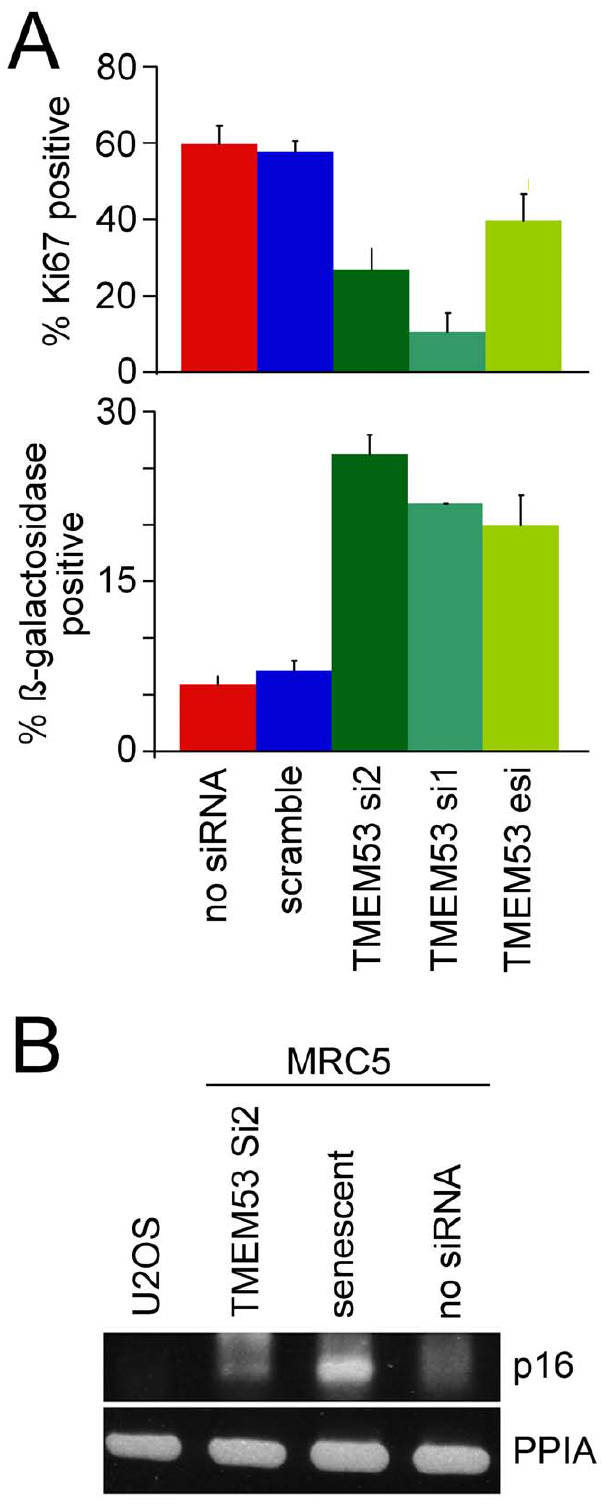
Figure 7. NET4/TMEM53 knockdown results in cell cycle withdrawal. (A) NET4/TMEM53 knockdown with both siRNAs and the esiRNA all resulted in a reduced number of actively proliferating cells as measured by Ki-67 staining (upper graph) and an increase in senescent cells as measured by ß-galactosidase staining (lower graph). The results from three separate experiments with standard errors are shown. (B) Differences between MRC5 and U2OS cells in